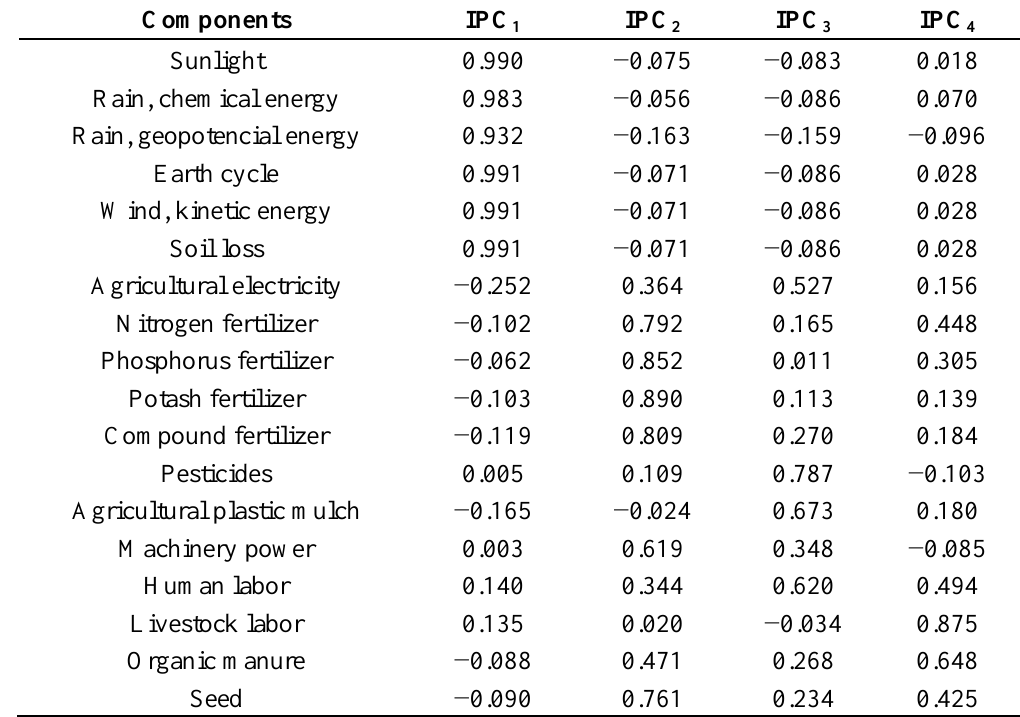
Table 4. Eigenvectors of the input intensity [24].